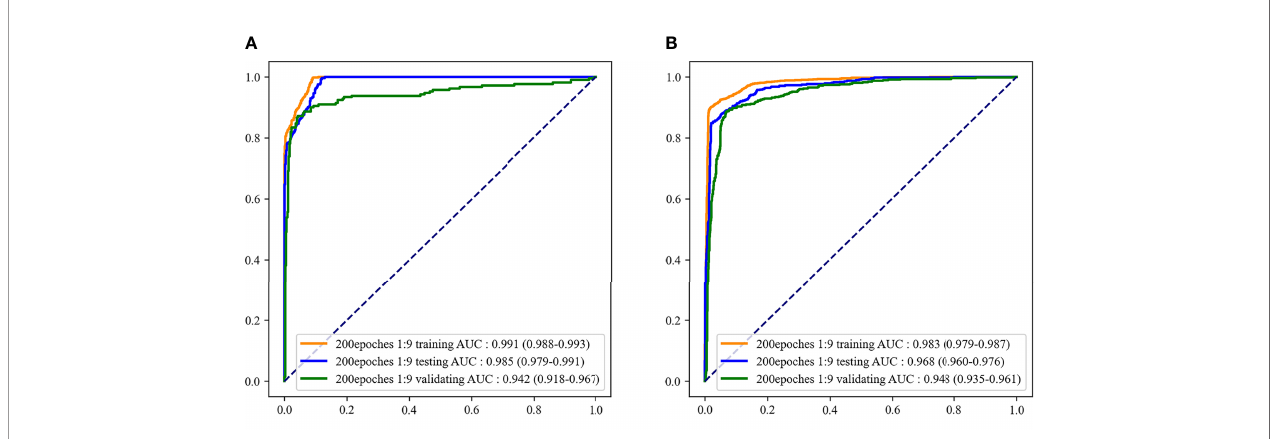
FIGURE 6 | The receiver operator characteristic (ROC) curves of the fi nal recognition models. (A) ROC curves of the two-classi fi cation model; (B) ROC curves of the three-classi fi cation